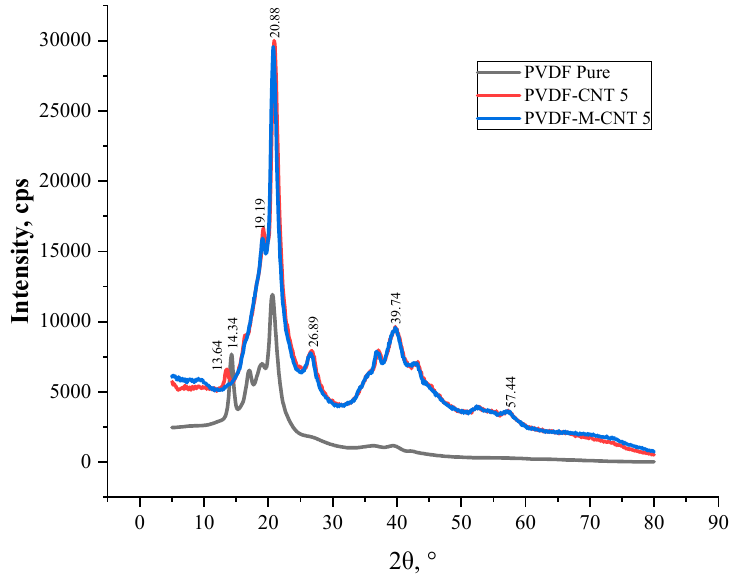
Figure 13. XRD patterns of PVDF and the unmodified and modified GNF-PVDF nanocomposites. Microstructural analysis of the nanocomposites was carried out using SEM. In the SEM images (Figure 14), MWCNT and GNF were not visible. However, the microstructure of the PVDF molecules was observed in the SEM images. In the SEM image of the MWCNT-PVDF nanocomposites (Figure 14b), PVDF molecules were found to be homogeneously dispersed. Further, a tougher bonding with a lesser number of voids indicates a toughened polymer. The SEM image of the GNF-PVDF nanocomposites (Figure 14b) shows that the PVDF molecules are tightly bonded; however, a large number of voids are observed, which result in a wide T g , delta T and other thermodynamic mechanical properties as compared to those of the MWCNT-PVDF nanocomposites. The pristine PVDF shrinks after drying. However, in the case of the filler-added PVDF, the shrinkage is reduced. Because of the shrinkage, the pure PVDF sample does not exhibit good mechanical